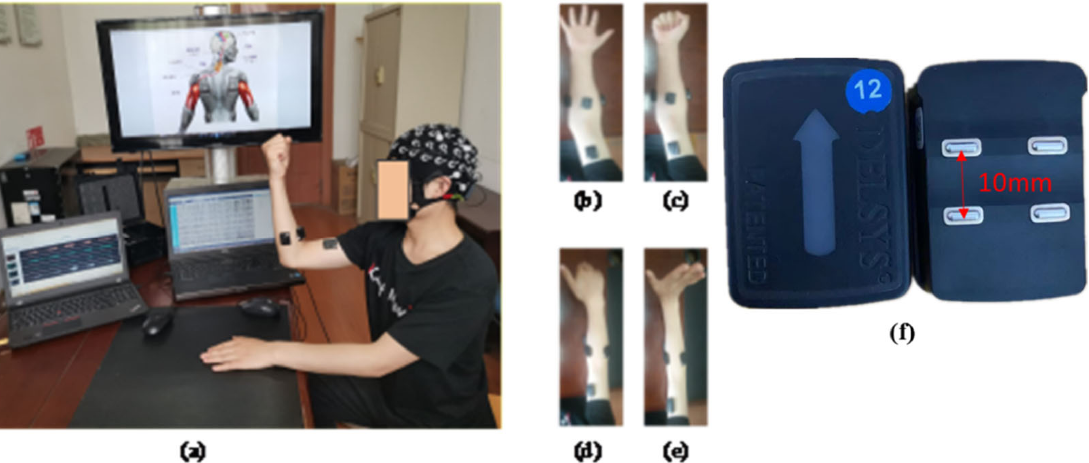
Figure 1. Setup for measuring motor tasks. ( a ) Experimental scene, ( b ) hand open, ( c ) hand closed, ( d ) wrist flexion, ( e ) wrist extension, ( f ) Delsys sEMG sensor diagram.